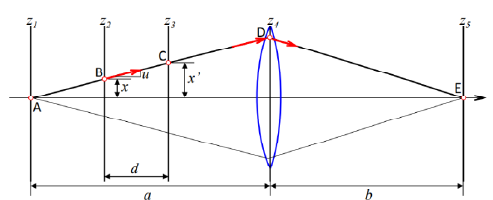
Figure 2. Relationship between ray matrix and lens